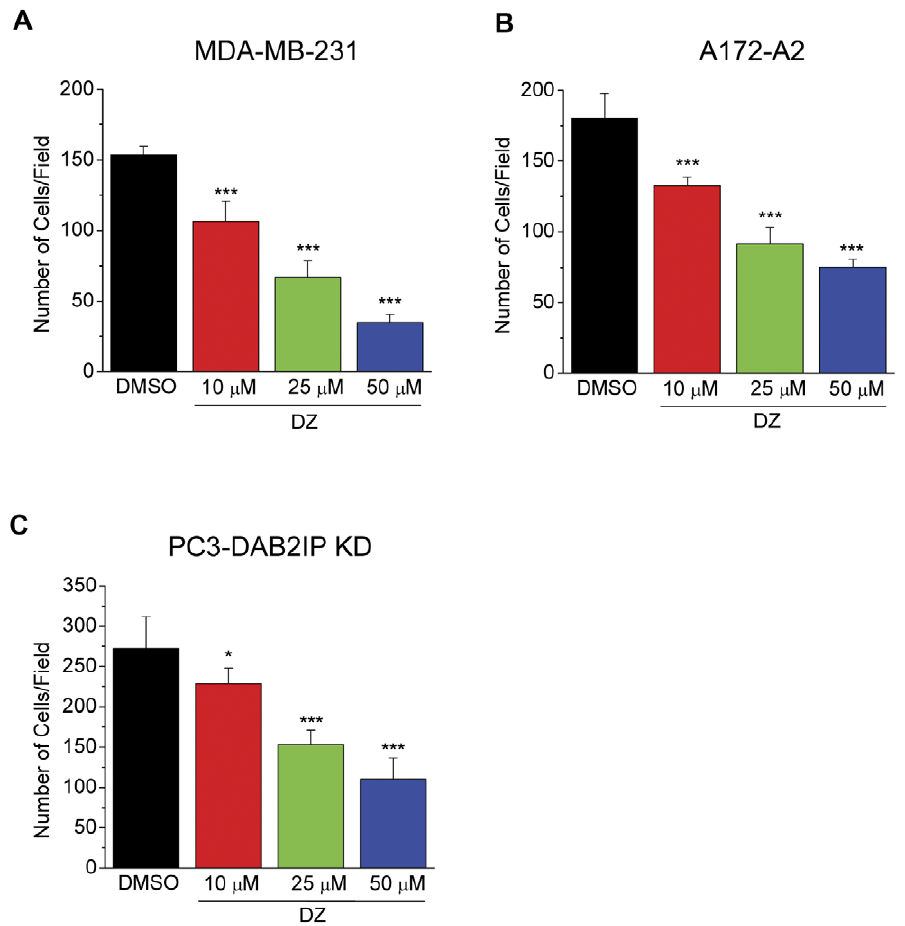
Figure 6. Integrin-mediated cell migration toward fibronectin is suppressed by doxazosin in a dose-dependent manner. MDA-MB- 231 (A), A172-A2 (B), and PC3-DAB2IP KD (C) cells were subject to haptotactic cell migration toward fibronectin as described previously (see Methods). Doxazosin at indicated concentrations was presented at the lower chamber of the Transwells. Cells were allowed to migrate toward fibronectin for 4 hours. Data represent average numbers of migrating cells from 6 randomly selected fields. DMSO was used as vehicle